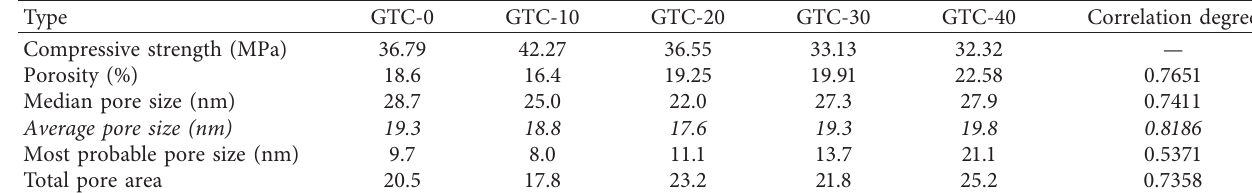
Table 7: Most grey correlation of compressive strength of GTC 0% to